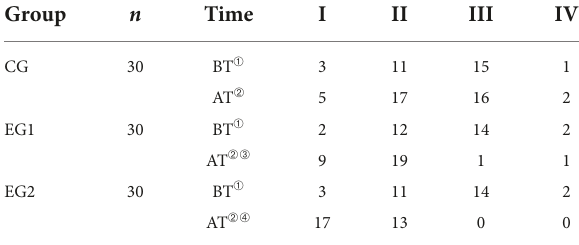
TABLE 3 Coma Recovery Scale revised (CRS-R) scale score of patients in the three groups ( ¯ x ± s, control group n = 30, experimental group 1 n = 30, experimental group 2 n = 30).